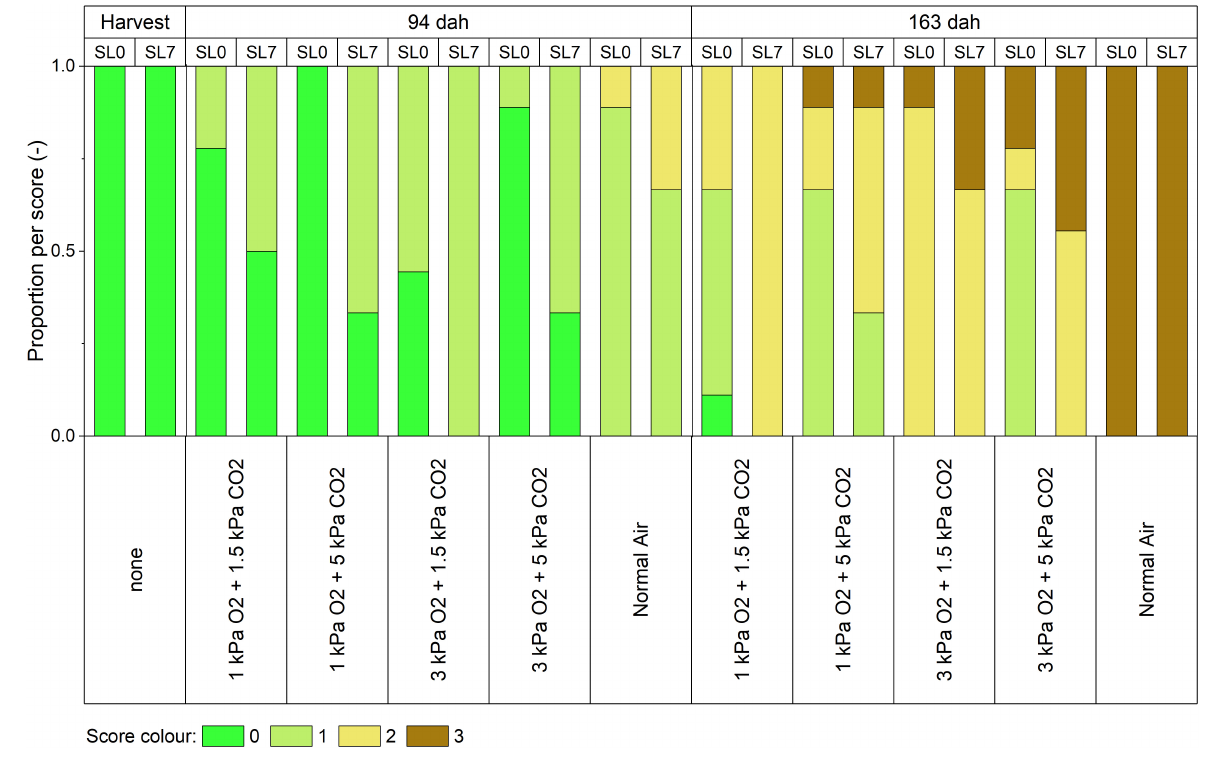
Table 1 the relative values of all aroma compounds of interest are shown per treatment and storage p -Value < 0.0001*